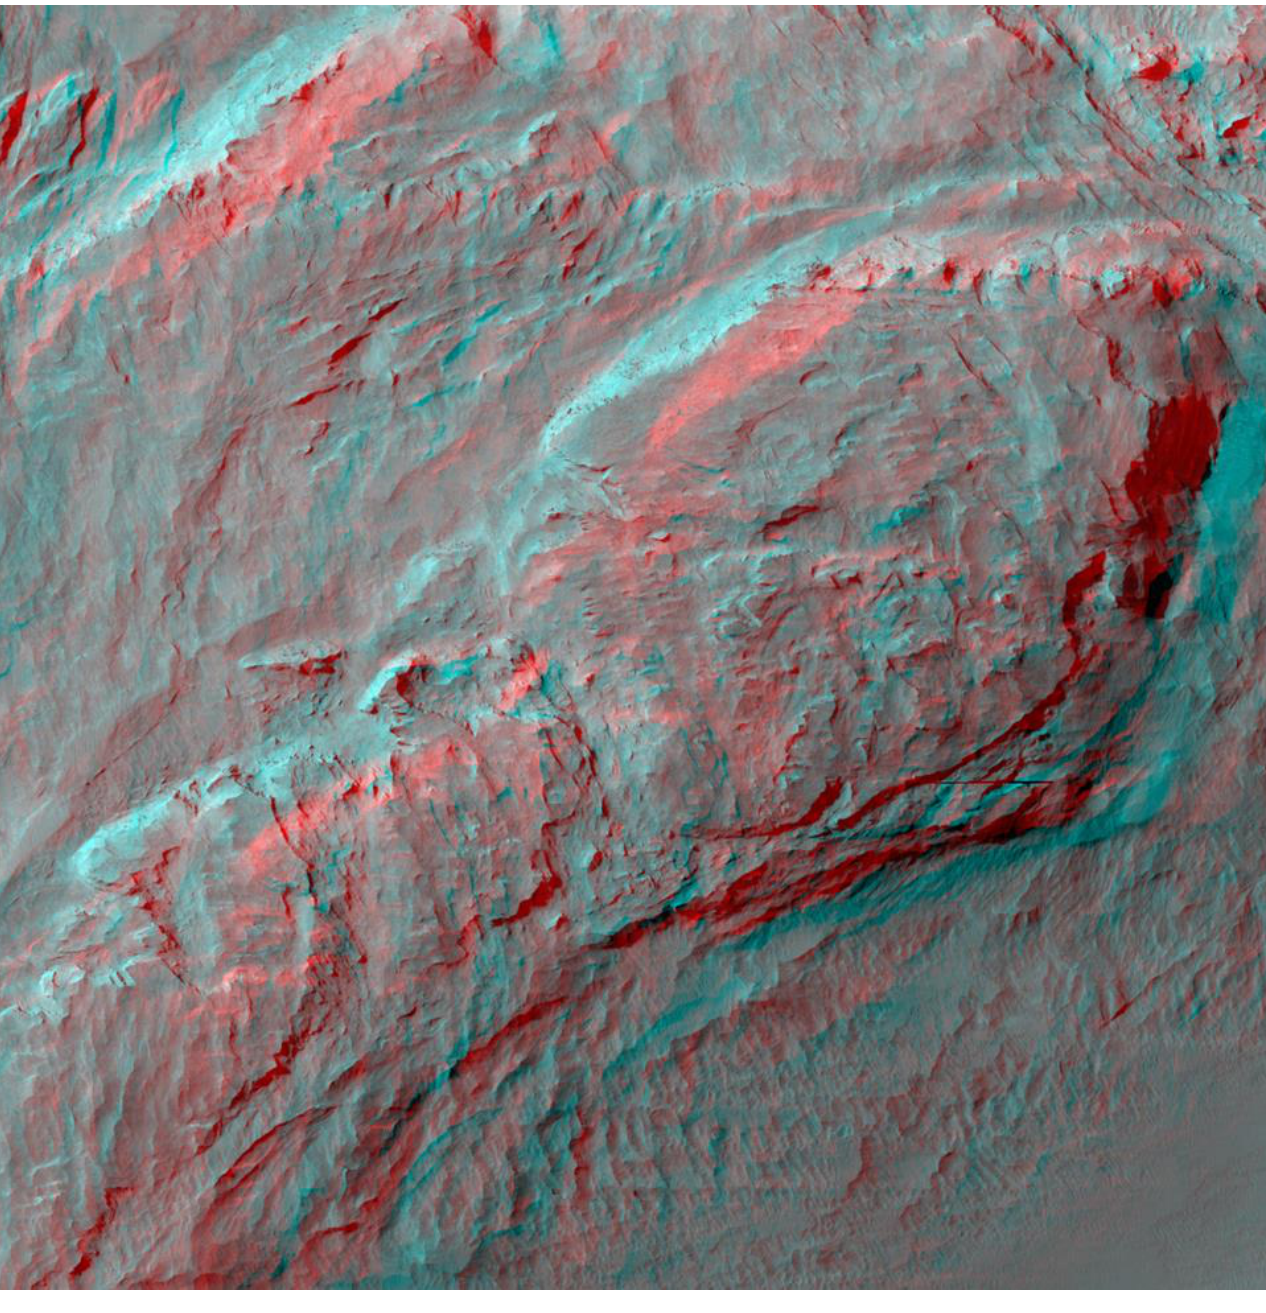
Figure 9. Anaglyph of lobate form shown in Figure 7. This feature has a convex cross profile with oversteepened distal and lateral sides. Image derived from HiRise Images ESP_018287_1755_ESP_018788_1755. Credit: NASA/JPL/University of Arizona.